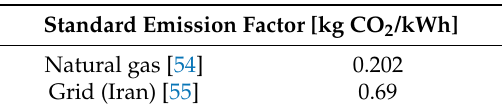
Table 6. Emission factor.